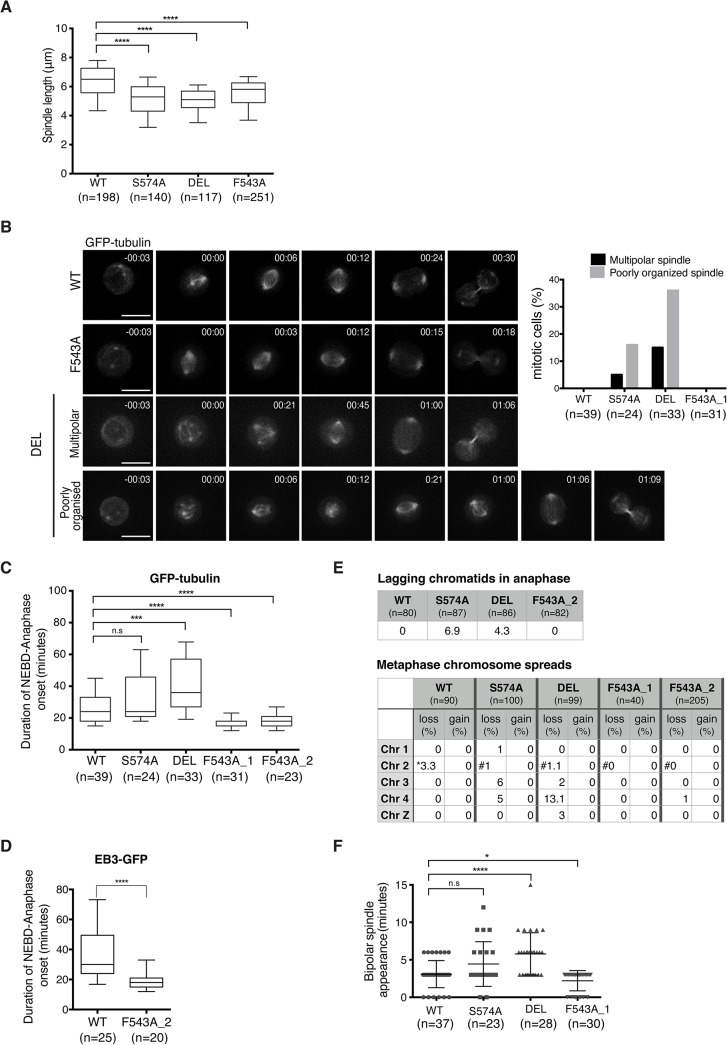
Spatially distinct residues in TACC3 dictate mitotic duration and fidelity.(A) Spindle length measured in 3D using Volocity. Number of cells analysed is indicated in graph (n). Student t-test (**** P < 0.0001). (B) Mitotic spindle morphologies (as described in main text) observed during time-lapse microscopy of GFP-tubulin-expressing TACC3 mutant cell lines. Representative still frames are shown on left. Scale bar = 5 μm. (C) Durations of NEBD to anaphase onset obtained from time-lapse microscopy performed on GFP-tubulin-expressing TACC3 mutant cell lines. F543A_1 and F543A_2 cells represent independently derived clones. Note that we observed no correlation between GFP levels and mitotic timing, or between mitotic timing and time of NEBD with respect to duration of filming in these experiments. Box plot shows 10–90 percentiles for each genotype. Number of cells analysed is indicated in graph (n). Mann Whitney nonparametric t-test (**** P < 0.0001, *** P < 0.001 and n.s. stands for ‘no significance’). (D) Durations of NEBD to anaphase onset obtained from time-lapse microscopy performed on EB3-GFP-expressing cells. Box plot shows 10–90 percentiles. Number of cells analysed is indicated in the graph (n). Mann Whitney nonparametric t-test. (**** P < 0.0001). (E) Analysis of chromosome segregation. Top table shows percentage of lagging chromatids seen during anaphase in fixed cells. Bottom table shows results from metaphase chromosome (chr) spreads. Number of autosomes 1, 2, 3, 4 and the sex chromosome, Z was analysed in cells. Frequencies of loss or gain of a single copy of individual chromosomes are indicated. Note that WT DT40 cells are trisomic for chromosome 2, whilst all the TACC3 mutants are diploid. Therefore, cells with two or three copies of chromosome 2’s are marked with ‘*’ or ‘#’, respectively. (F) Plot depicts time between NEBD and bipolar spindle appearance in time-lapse microscopy from Fig 7B. Cells with multipolar spindles and cells in which one of the two spindle poles was outside of the Z stack range for these time points were excluded from analysis. Number of cells analysed is indicated in graph (n). Mann Whitney nonparametric t-test (* P = 0.04, **** P < 0.0001).